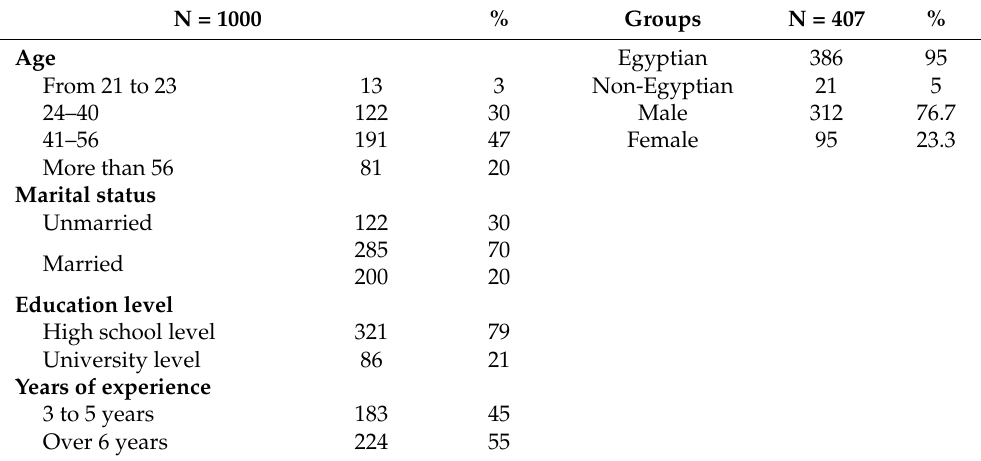
Table 1. The employees